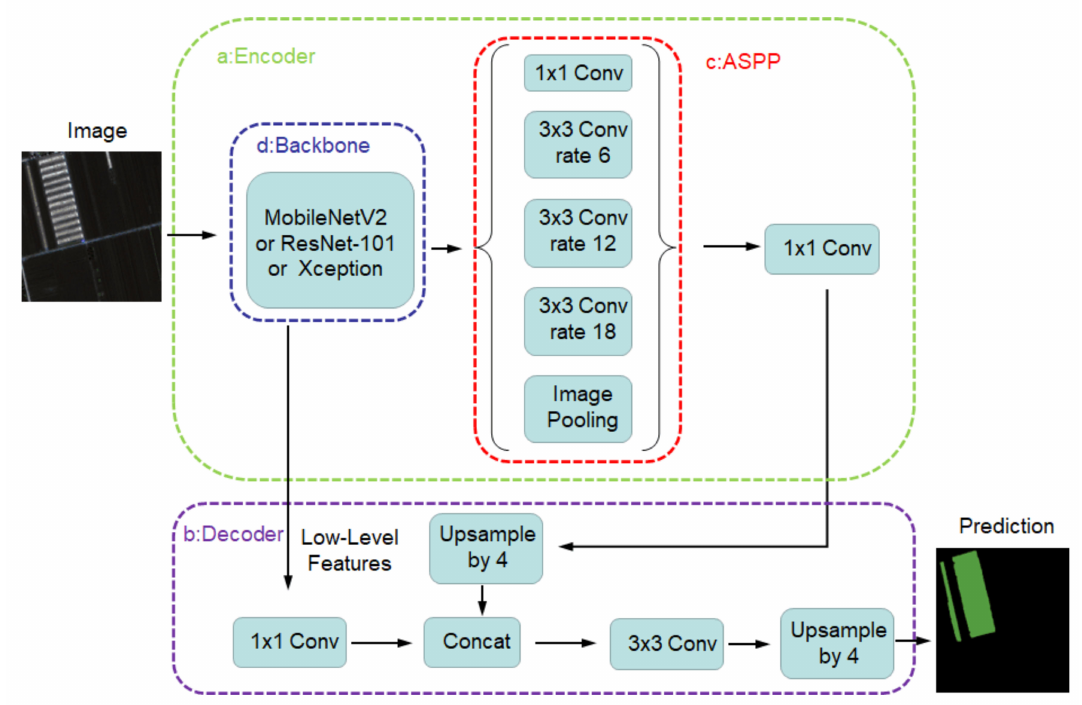
Figure 6. DeepLabv3+ Model Network